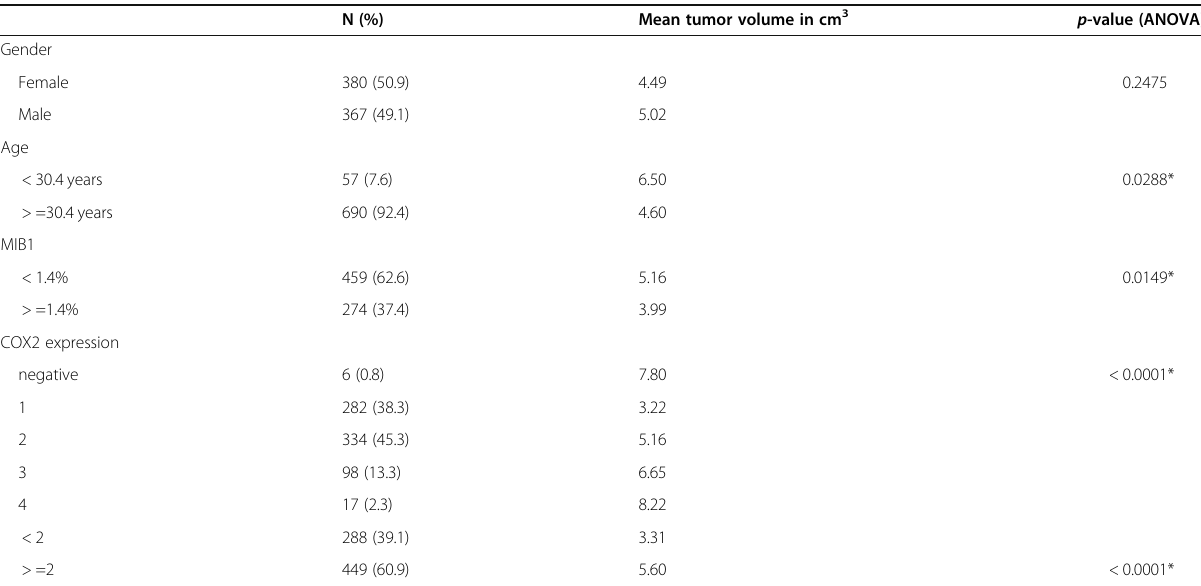
Table 1 Differences in preoperative volumetry N (%) Mean tumor volume in cm